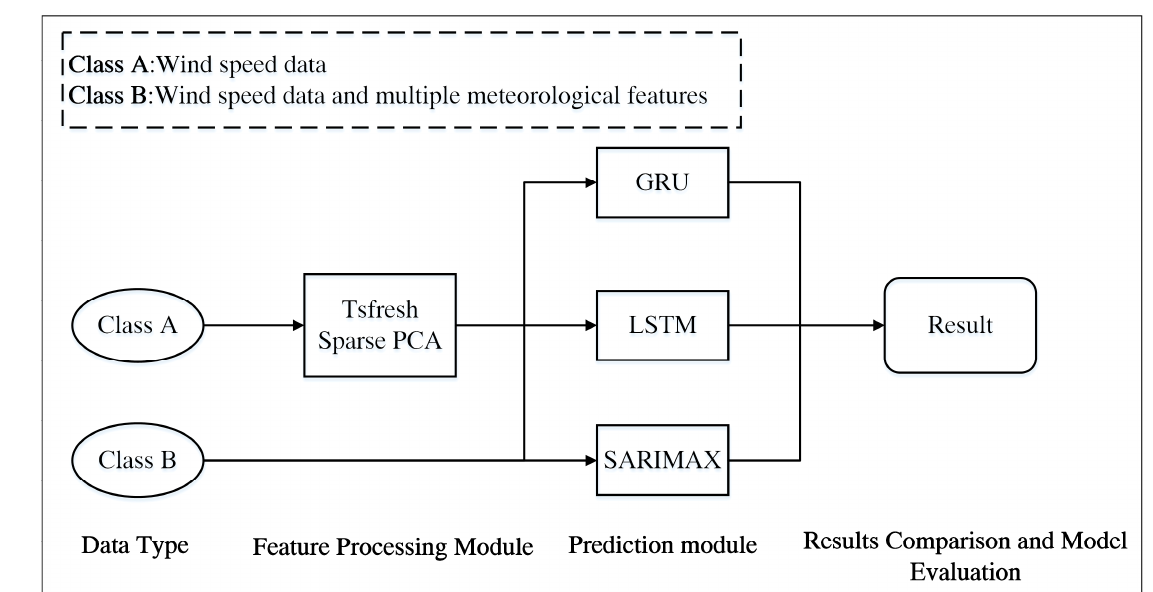
Figure 9. Experimental flow chart between dataset and model. In terms of SARIMAX model parameter configuration, the parameters of the SARI- MAX model were found by grid search to find the optimal hyperparameters. The LSTM network used a four-layer network structure, with the second and third layers being the hidden layers. The GRU network used a three-layer network structure, with the second layer being the hidden layer. GRU and LSTM networks used the same initial parameters, which included epoch, learning_rate, dropout, and activation function, etc. The hyperpa- training phase.